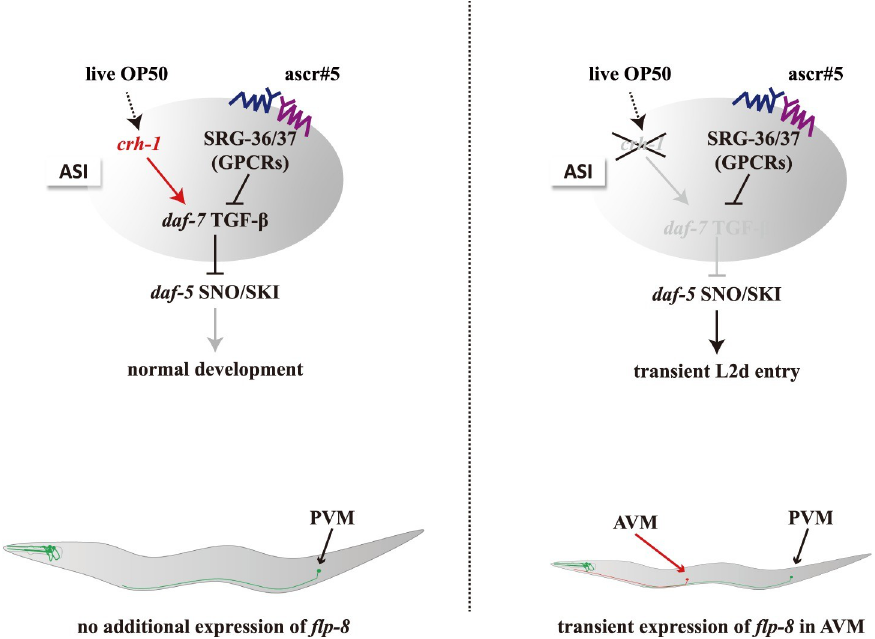
Fig 7. A model of the role of CRH-1 in ascr#5-mediated L2d formation. CRH-1 positively regulates dauer- inhibiting daf-7 TGF- β expression in the ascr#5-sensing ASI neurons. In crh-1 mutants, the decreased daf-7 TGF- β expression provides a sensitized genetic background for further ascr#5-mediated daf-7 TGF- β repression via srg-36/37 GPCRs which leads to transient L2d formation and flp-8 expression of AAP-TRN.